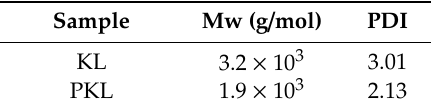
Table 2. GPC Analysis of KL and